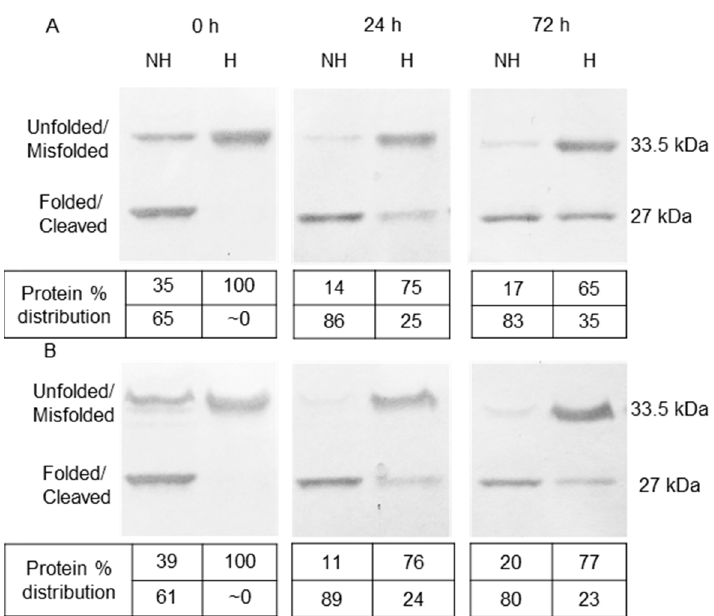
Figure 5. OmpT refolding in the presence and absence of LPS. ( A ) OmpT IBs refolded in absence of LPS. ( B ) OmpT IBs refolded in the presence of 4.5 mg/mL LPS. Samples were collected at 0, 24, and LPS. ( B ) OmpT IBs refolded in the presence of 4.5 mg / mL LPS. Samples were collected at 0, 24, and 72